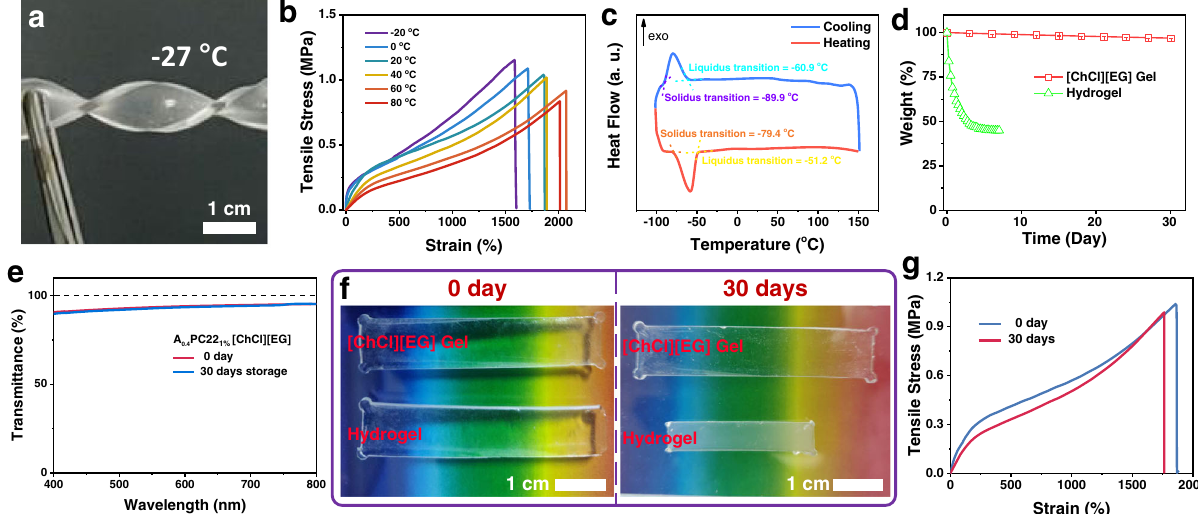
Fig. 6 | Anti-freezingand anti-dryingproperties. a Twisting anA 0.4 PC22 1% [ChCl] [EG]gelaftercooledto − 27°C. b Tensilestress-straincurvesofanA 0.4 PC22 1% [ChCl] [EG] gel at various temperatures. c DSC curve of an A 0.4 PC22 1% [ChCl][EG] gel. d Weighs of an A 0.4 PC22 1% [ChCl][EG] gel and a hydrogel stored under ambient conditions. e TransmissionspectraofanA 0.4 PC22 1% [ChCl][EG]gelbeforeandafter